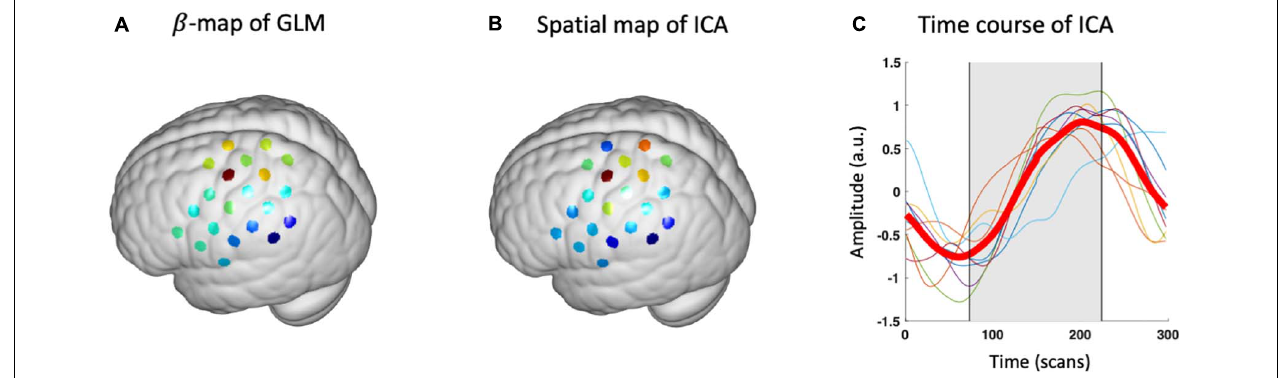
FIGURE 9 | Group-level results of GLM and ICA. (A) β -map of conventional GLM analysis. (B) Group-level spatial map of ICA (z-map). (C) Group-level block-averaged time course (bold red line) and individual time courses (thin lines). Gray rectangle denotes the period of the